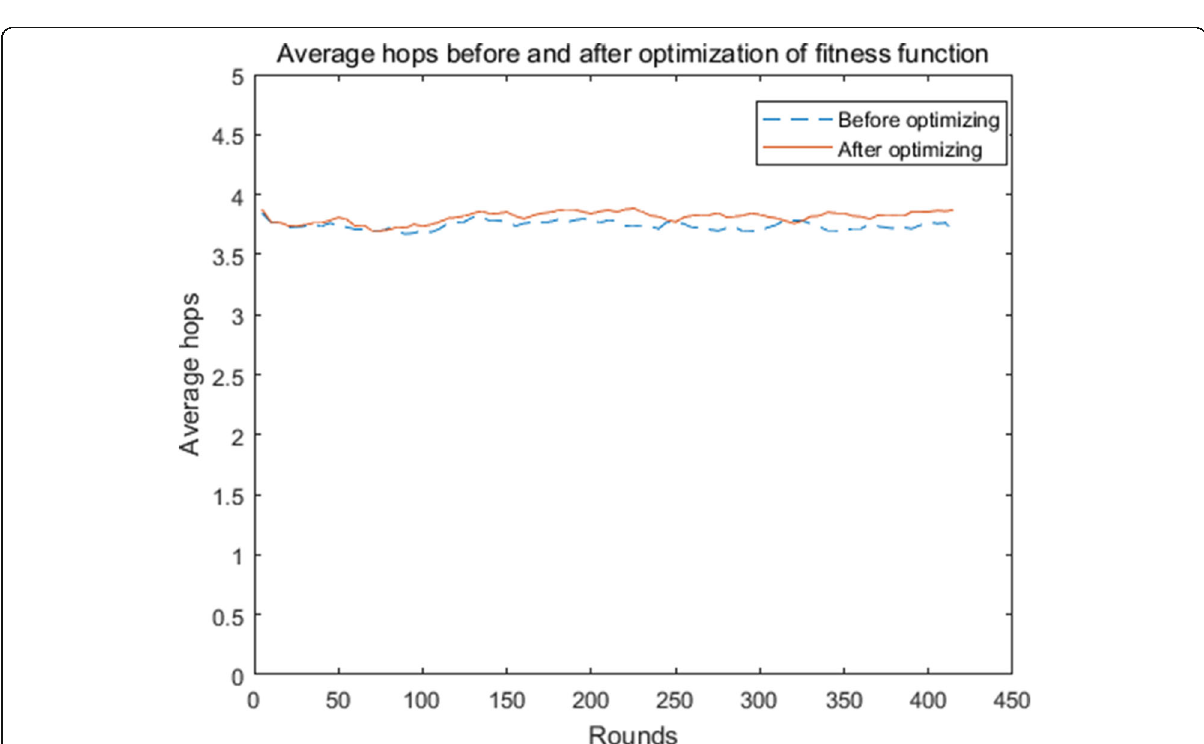
Fig. 16 The change of average single-hop distance before and after the improvement of fitness function. It shows the influence of the improvement of fitness function on the average number of communication